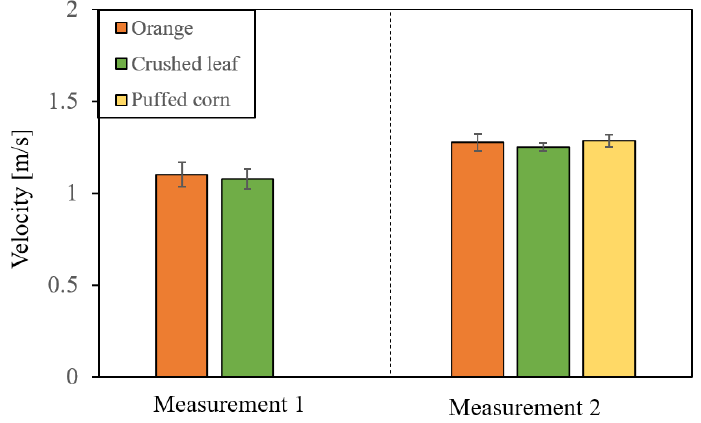
Figure 7. Surface velocity by different particle types.